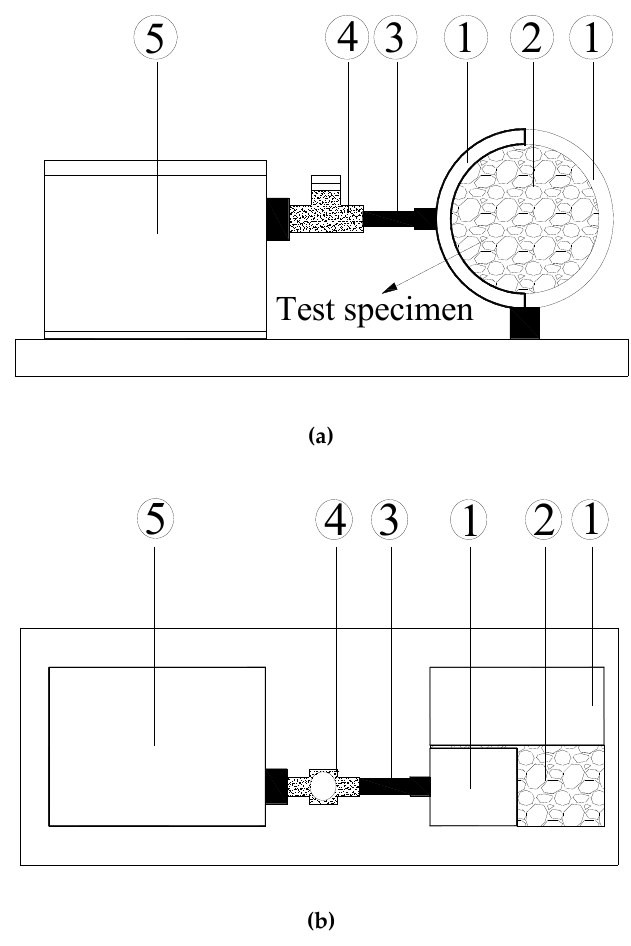
Figure 4. Schematic diagram of the direct shear apparatus: ( a ) Cross-sectional view; ( b ) Plane view. ① shear box ② test specimen ③ loading rod ④ load cell ⑤ motor. 196